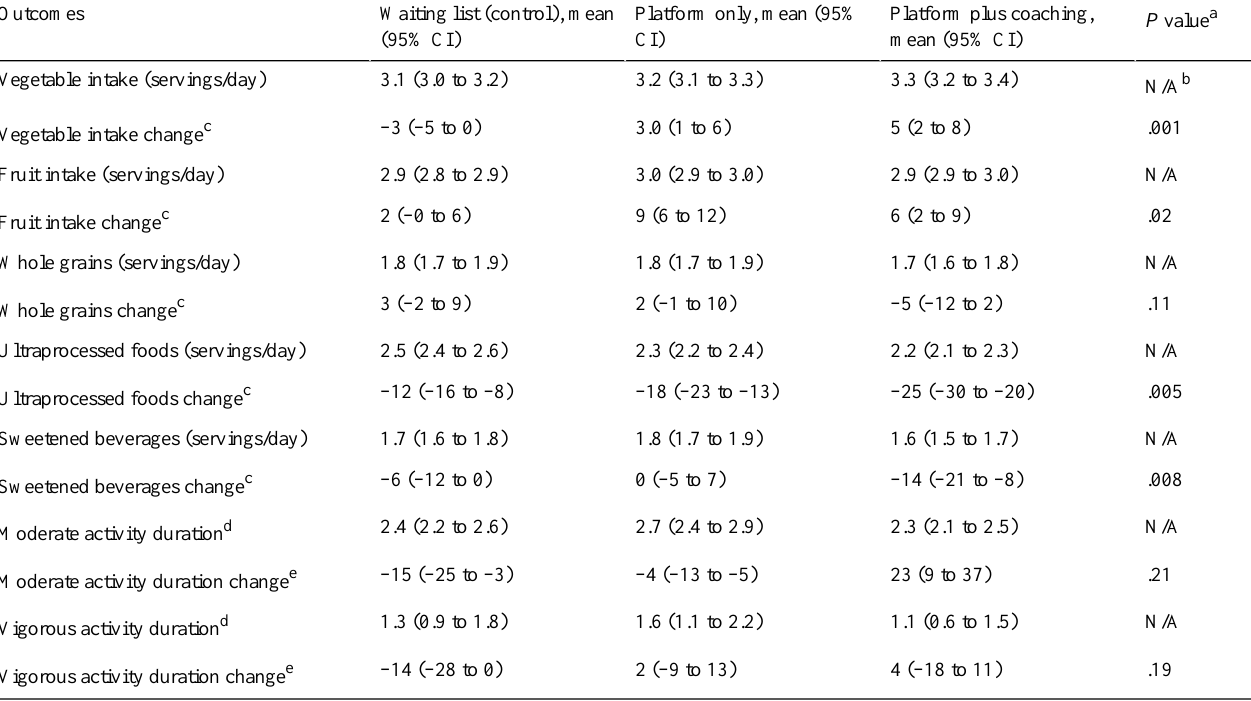
Table 3. Dietary and physical activity habits at 24 weeks and percent change from baseline (95% CI) across study